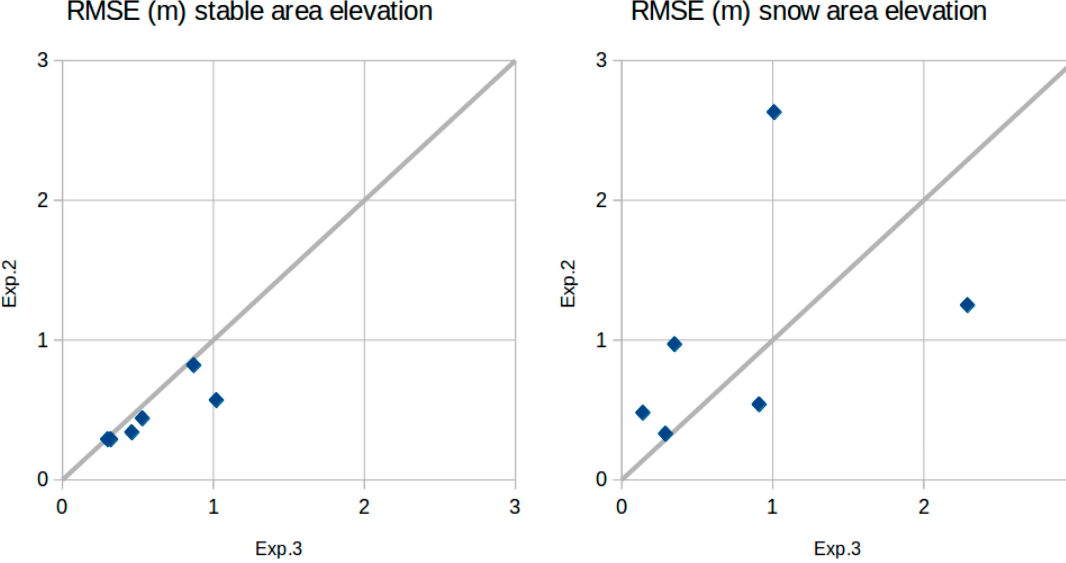
Figure 8. Comparison of the RMSE on the surface elevation from Exp.2 and Exp.3 over the snow surface and the stable area.